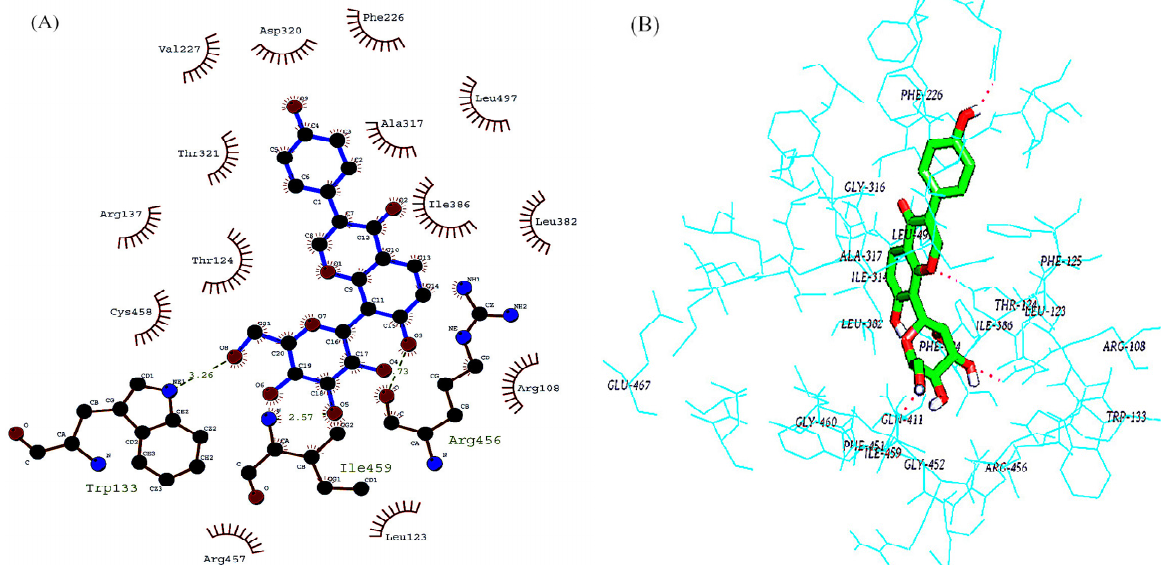
Figure 5. Molecular docking of interactions between puerarin and CYP1A2. ( A ) Ligplus; ( B )